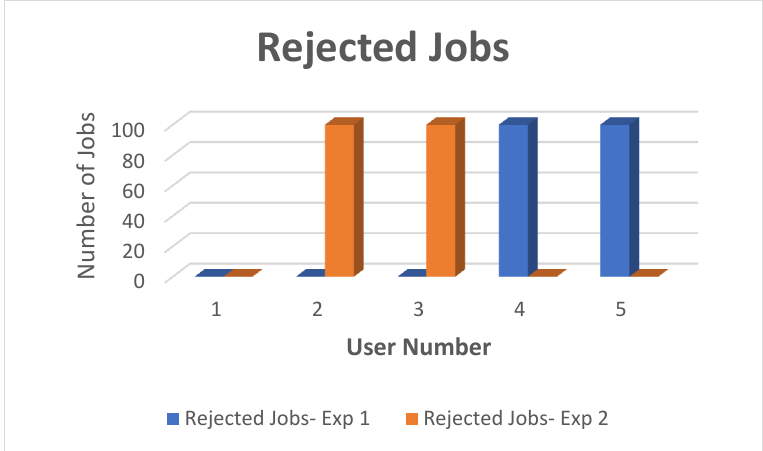
Figure 12. Job Rejections for Both sections—Experiment 2.